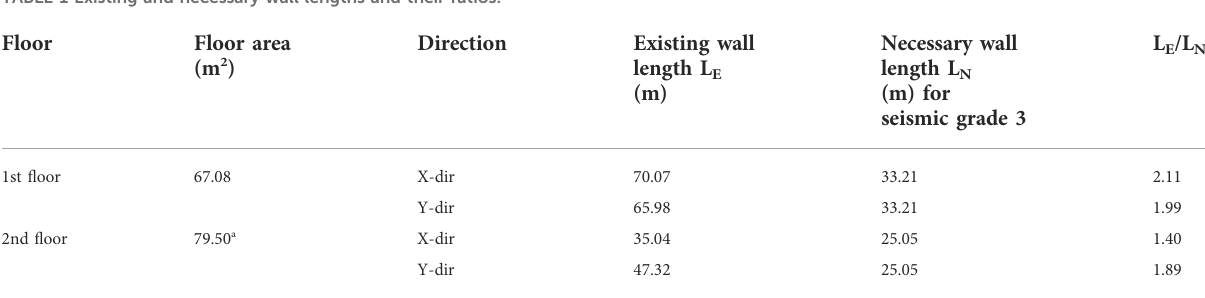
TABLE 1 Existing and necessary wall lengths and their